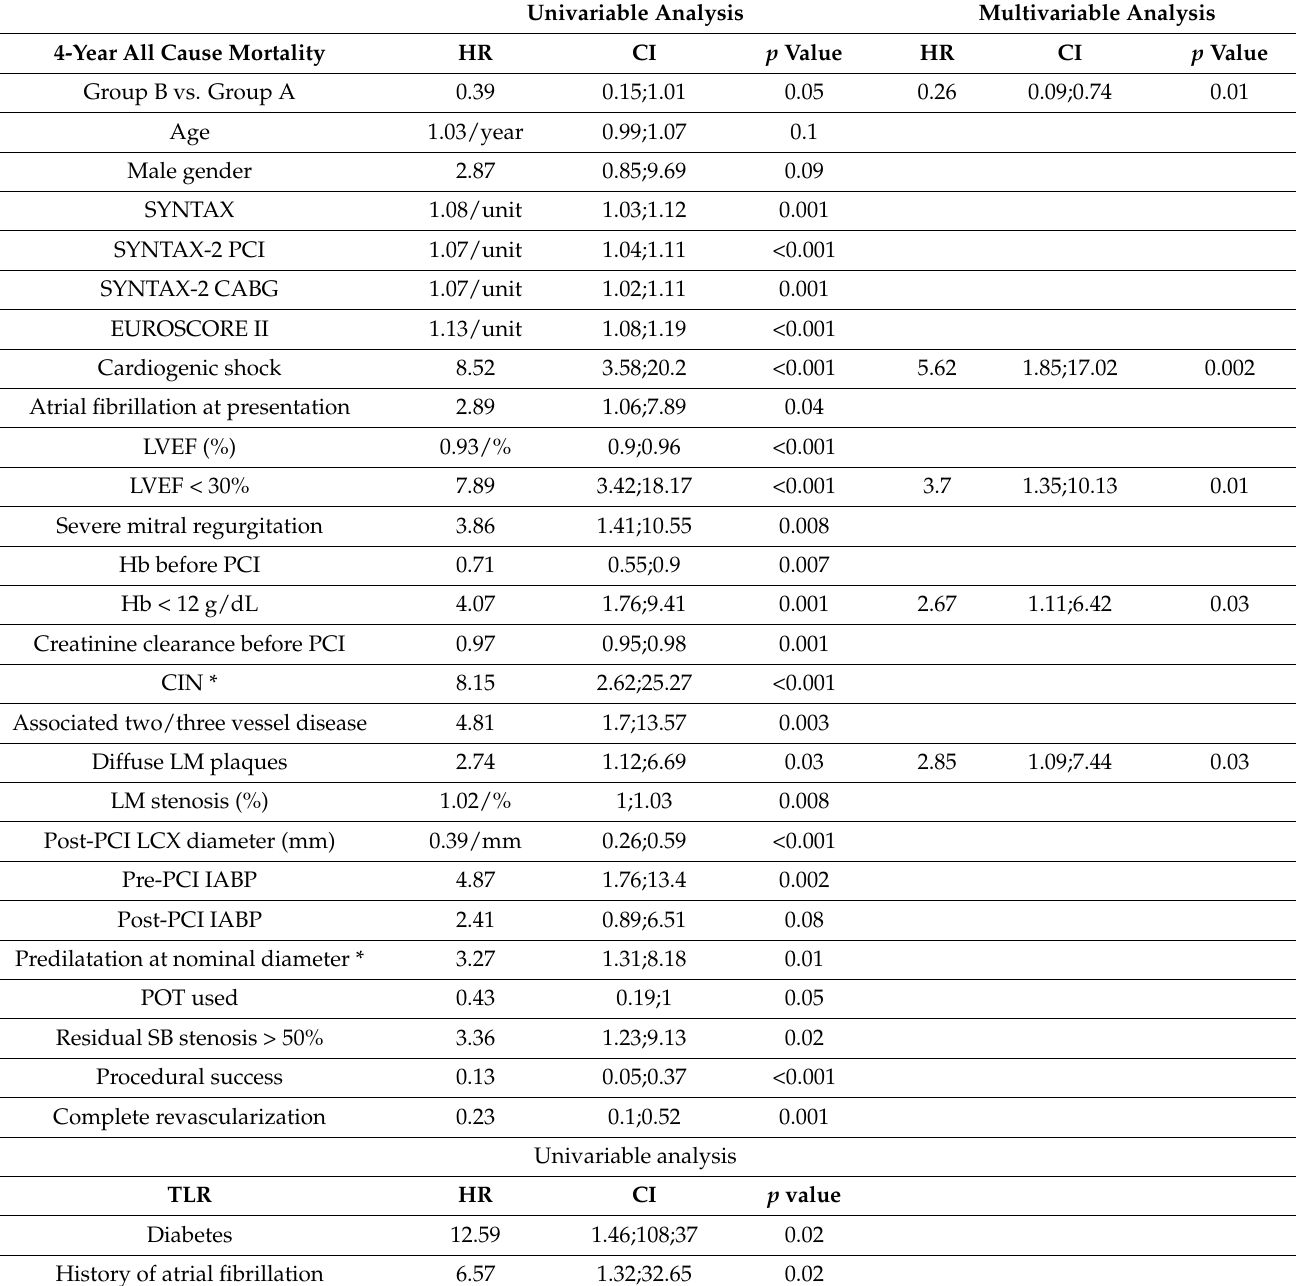
Table 6. Predictors of late mortality and target lesion revascularization according to the stent strategy in patients with unprotected left main coronary artery disease and acute coronary syndrome (Group A—one stent strategy; Group B—two stent strategy). Univariable Analysis Multivariable